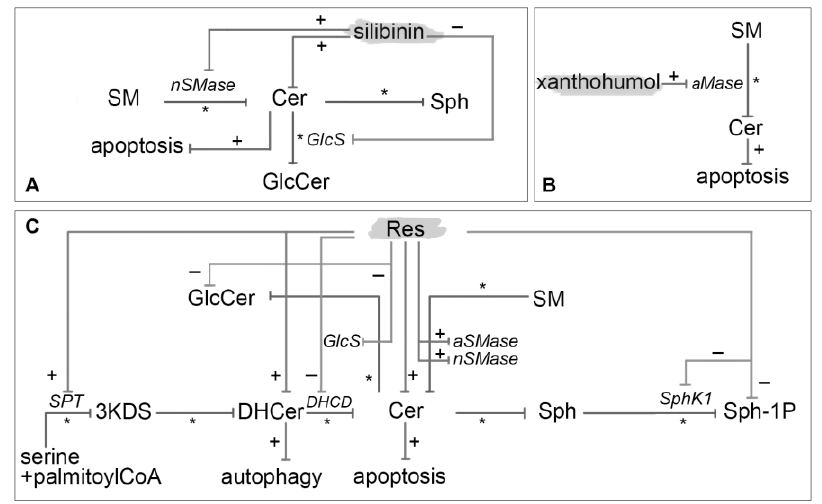
Figure 6. Mechanism of modulation on sphingolipids by silibinin (A), xanthohumol (B) and Res (C). It is depicted with an asterisk (*) enzymatic pathway, with plus (+) red-regulated pathway and with minus (−) down-regulation ones.